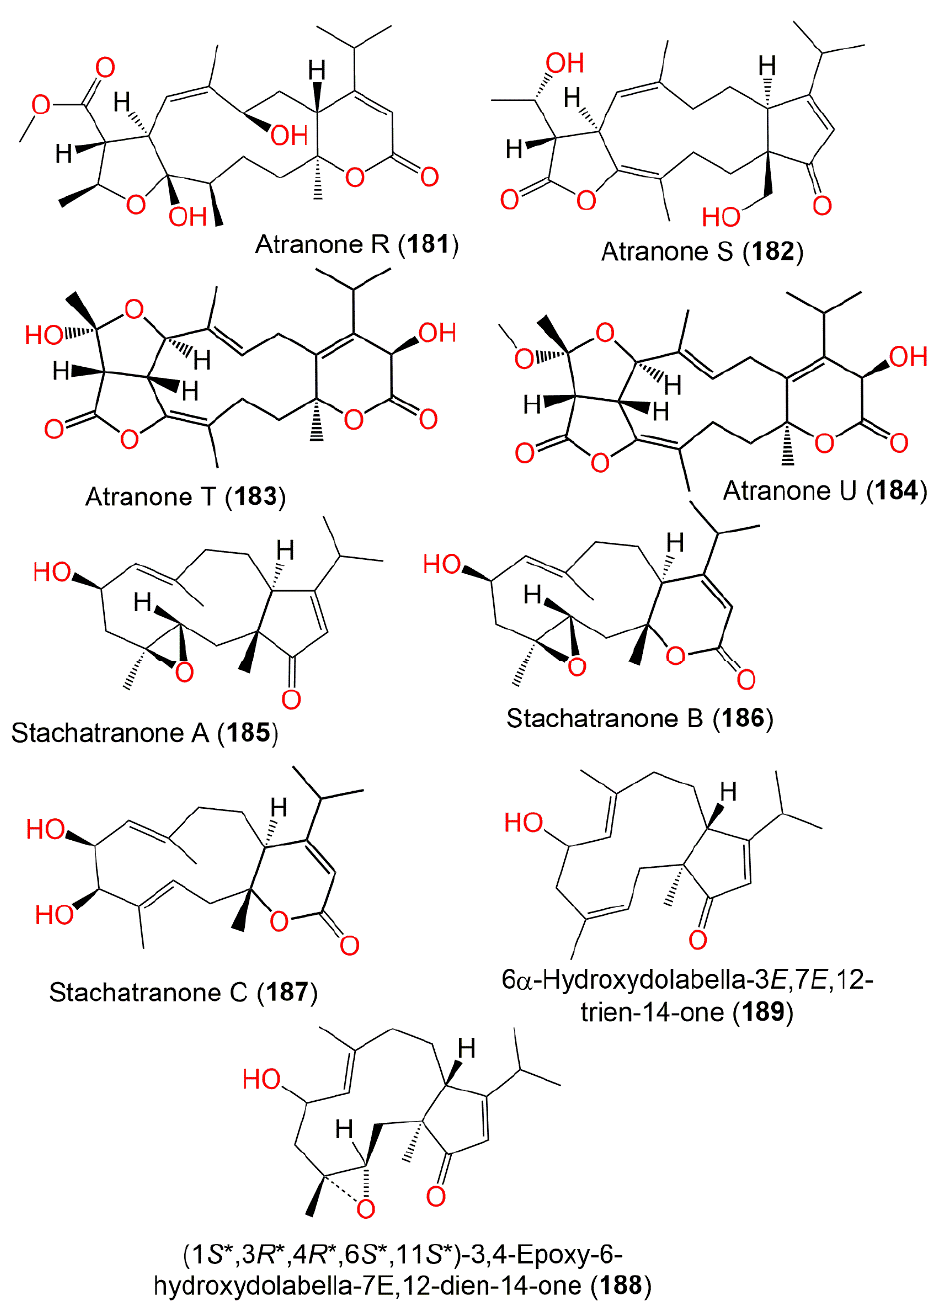
Figure 23. Structures of atranones ( 181 – 184 ) and dolabellanes ( 185 – 190 ) reported from S. chartarum . Two new atranones, T ( 183 ) and U ( 184 ), and three formerly reported analogs, 162 , 180 , and 187, were purified from the broth and mycelia EtOAc extract of S. chartarum by SiO 2 CC and RP-HPLC. They were structurally verified by spectroscopic and calculated ECD analyses. Compound 183 is atranone C ( 165 ) C-13-hydroxy analog with 1S/6R/7R/13R/21S/22R configuration, however, 184 is a C22 methoxylated derivative of 183 . It was proposed that these metabolites are biosynthesized starting with GGPP (geranylgeranyl pyrophosphate), as shown in Scheme 10. The cytotoxic evaluation versus MG-63 (human osteosarcoma cells) revealed that 180 (IC 50 8.6 μ M) possessed promising cytotoxic capacity than 5-FU (5-fluorouracil, IC 50 10.4 μ M) in the MTT. Further, 180 effi- ciently promoted MG-63 apoptosis, accompanied with G0/G1 cell cycle arrest. Thus, this compound could be further developed to a promising antitumor agent [62].